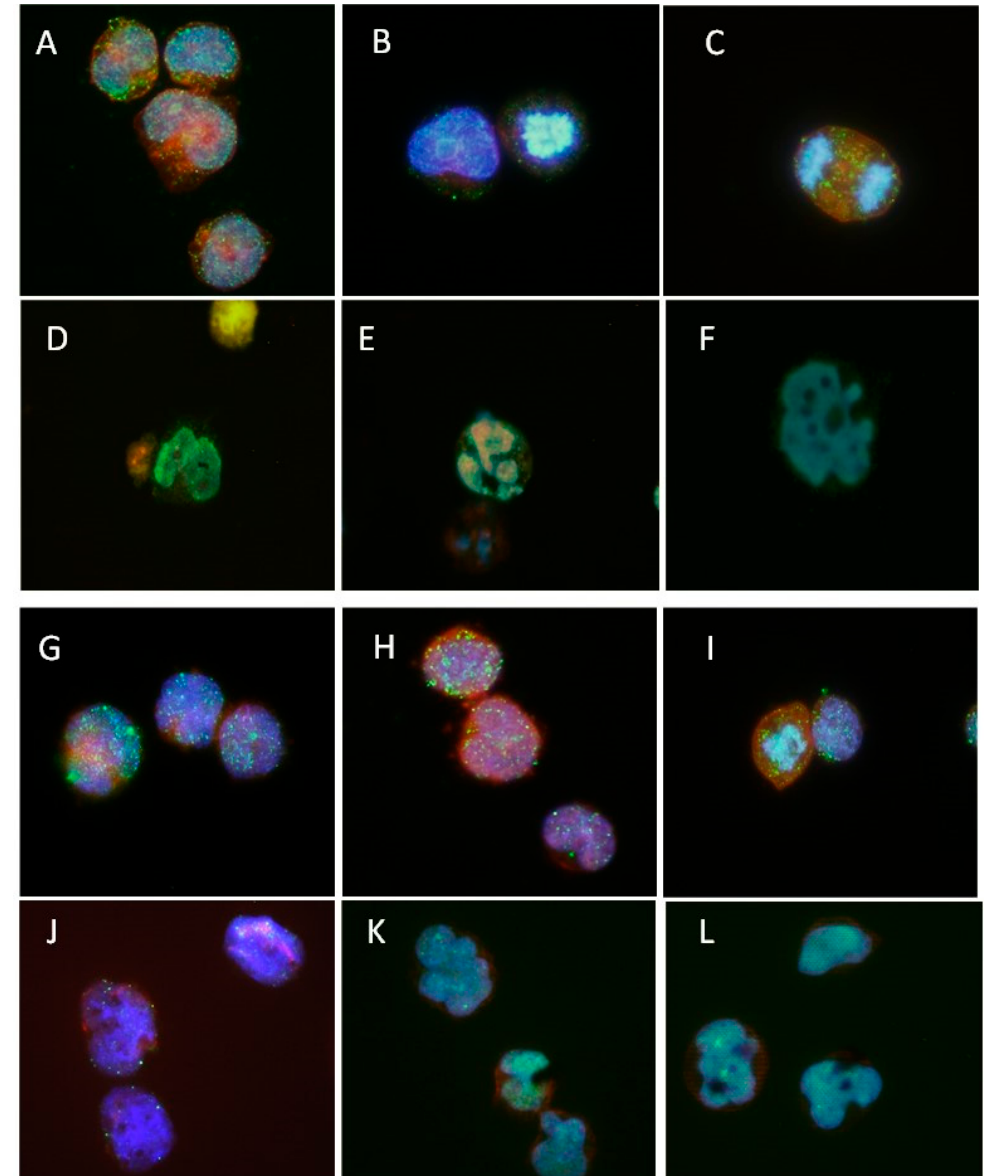
Figure 4. Immunofluorescence for IKZF1 in cultured SUP-B15 and NALM1. Untreated ( A – C ) and givinostat-treated ( D – F ) SUP-B15, and untreated ( G – I ) and givinostat-treated ( J – L ) NALM1 were subjected to immunofluorescence microscopy with representative cells shown for each group. The cytoskeleton (F-actin) was highlighted with Alexa 568 phalloidin (red), nuclei with DAPI (blue), and IKZF1 proteins with FITC-conjugated anti-rabbit antibodies (green). Image magnification (100× oil immersed fluorescence microscopy).